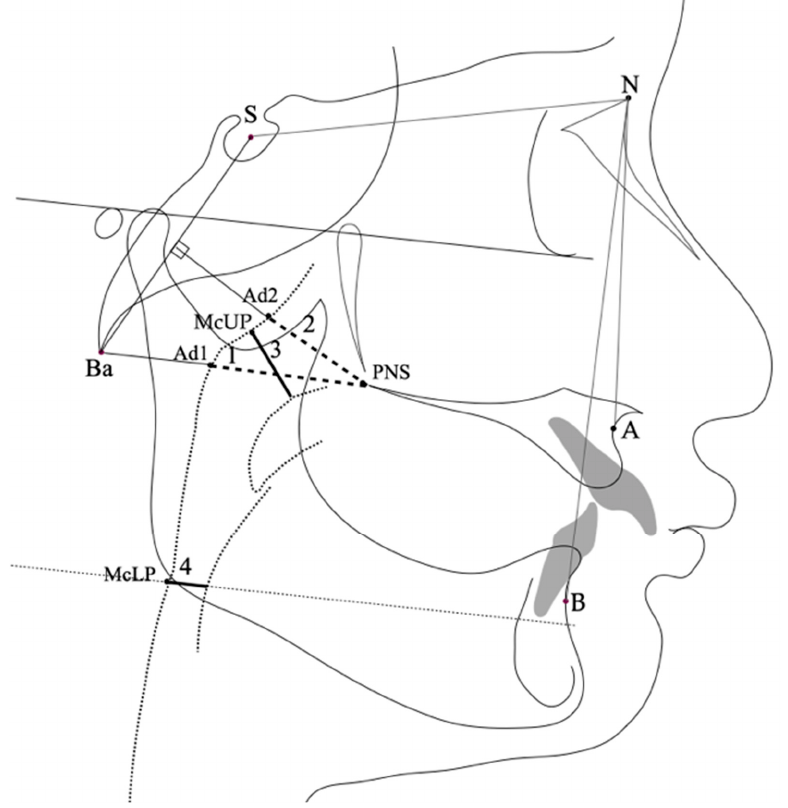
Figure 2. Reference points and lines on the cephalometric radiograph. Ba: basion; N: nasion; PNS: posterior nasal spine; S: sella; B: supramentale; A: subspinale. Craniofacial measurements: SNA: the angle between the sella (S), nasion (N), and A; SNB: the angle between the sella (S), nasion (N), and B; ANB: the angle between A, N, and B; Ad1-PNS (1): the distance of the intersection point of the posterior pharyngeal wall and the line from PNS to Ba; Ad2-PNS (2): the distance of the intersection point of the posterior pharyngeal wall and the line from the midpoint of the line from S to Ba; McUP (3): the shortest distance between the soft palate and the posterior pharyngeal wall; McLP (4): the shortest distance between the base of the tongue and the posterior pharyngeal wall.